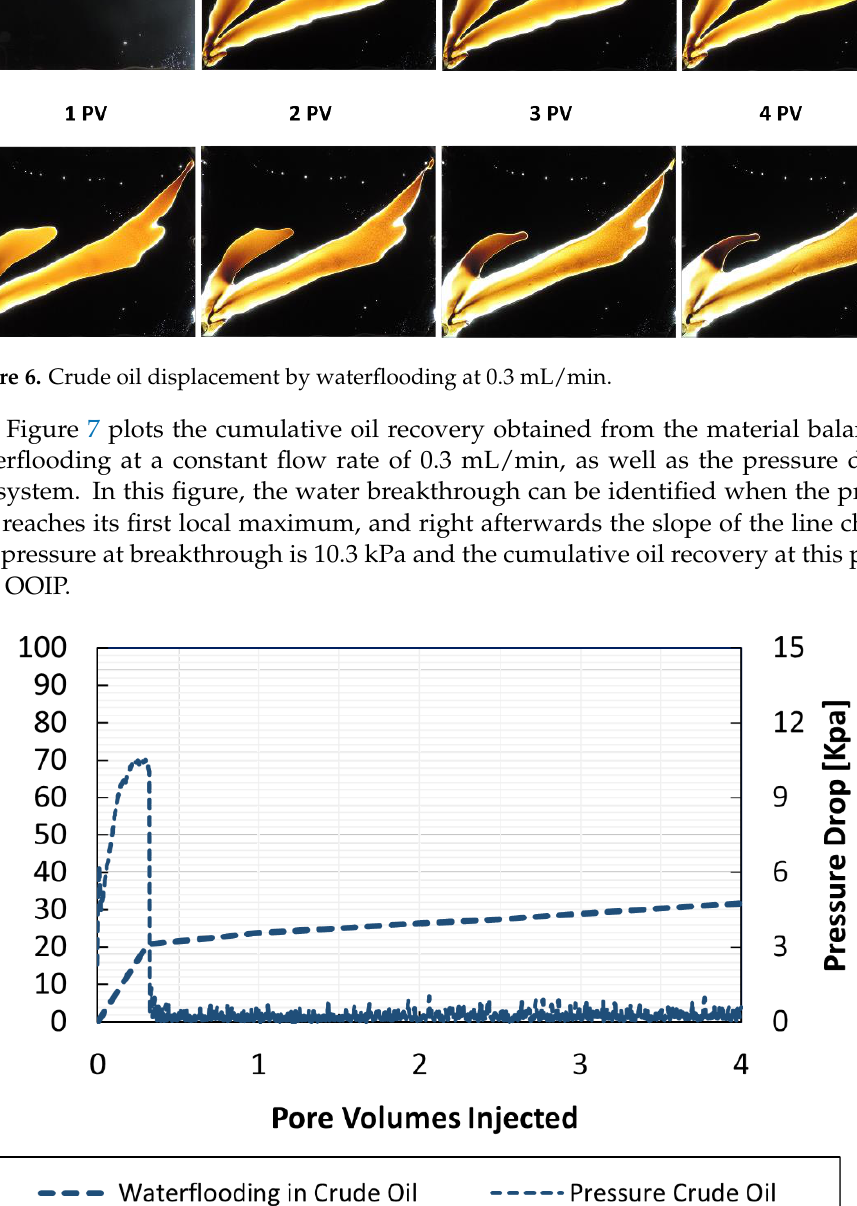
Figure 7. Oil recovery by waterflooding for crude